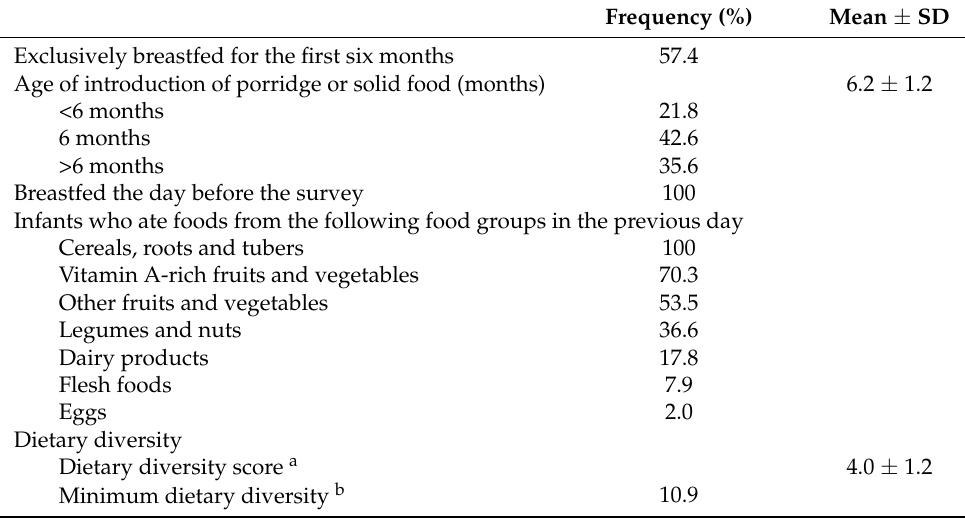
Table 2. Breastfeeding and complementary feeding practices of infants ( n =